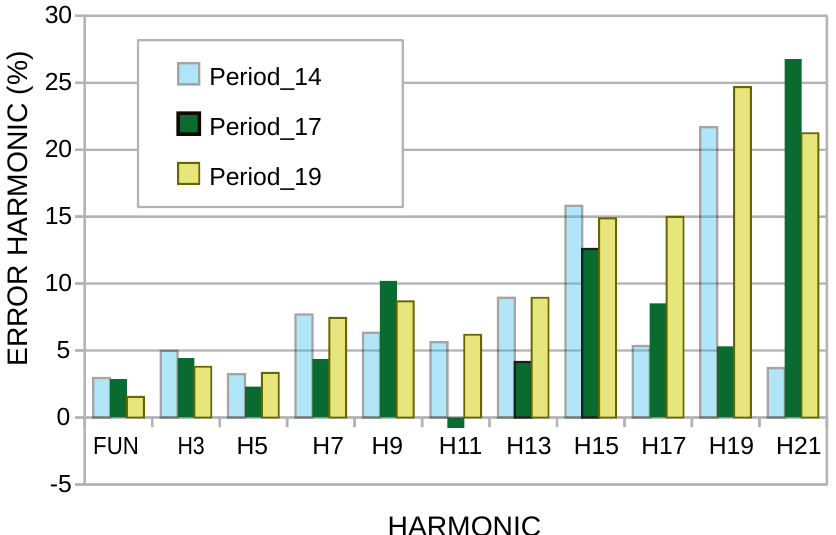
Figure 11. Harmonic error rate of periods 14, 17, and 19.